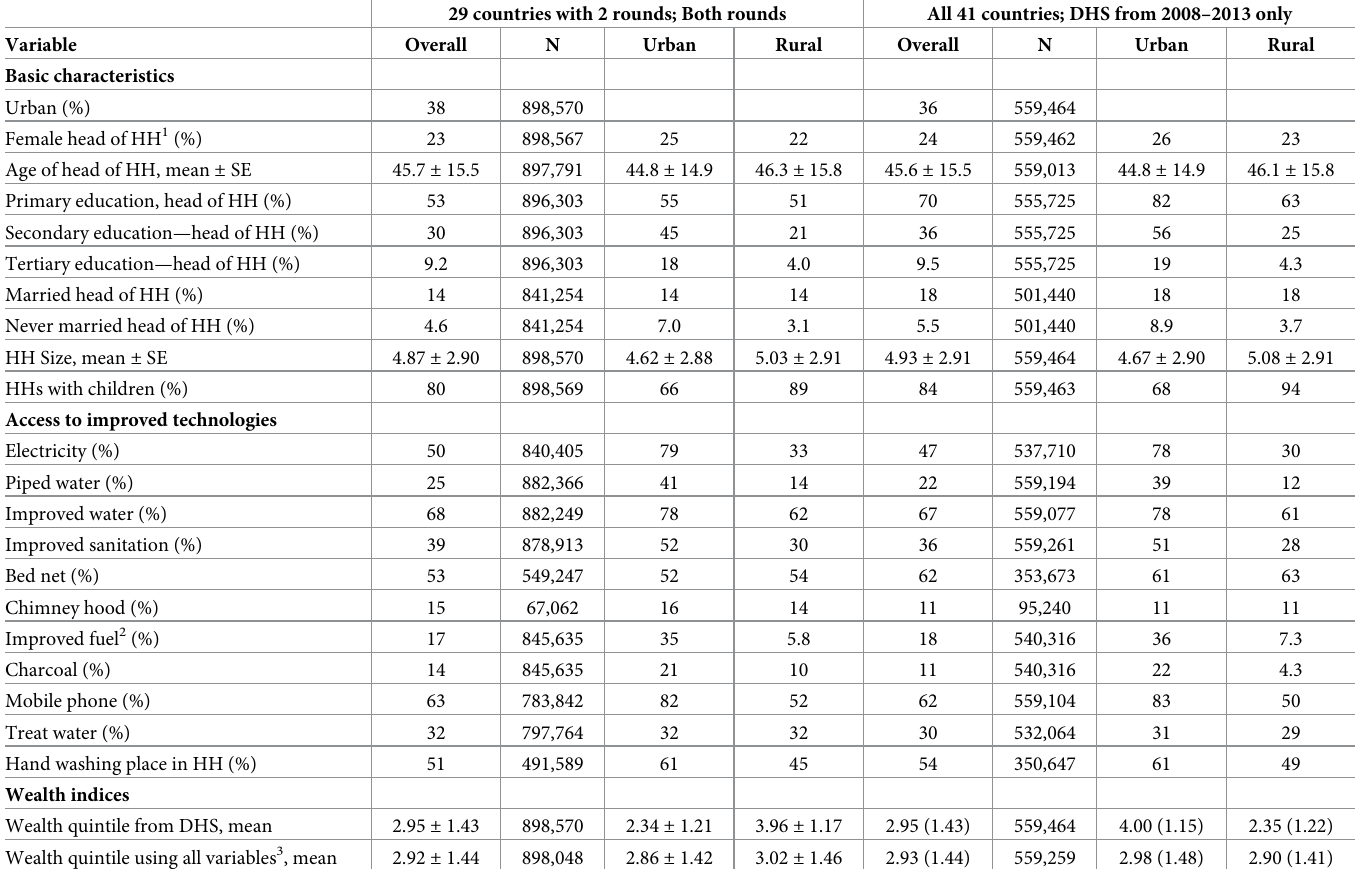
Table 1. Variables and descriptive statistics, overall and for urban and rural subsamples. 29 countries with 2 rounds; Both